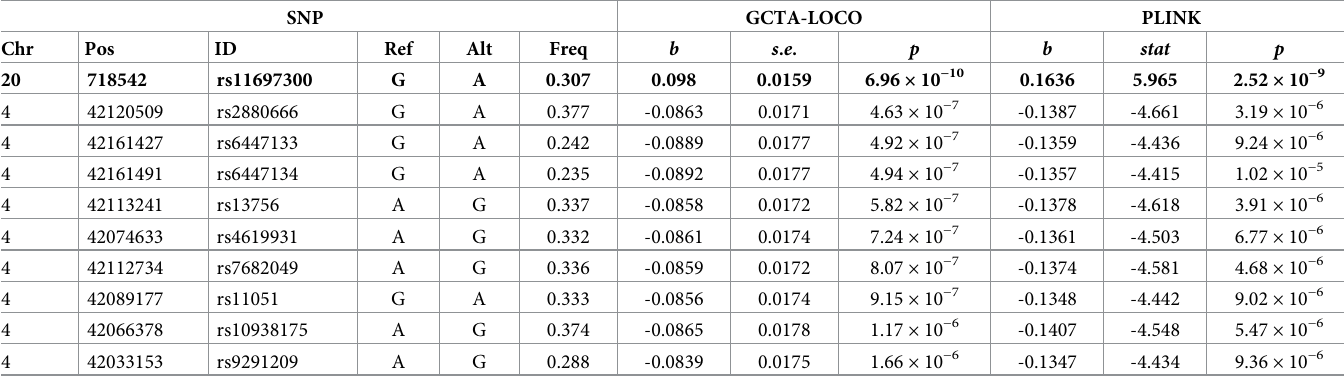
Table 1. Summary of results of genetic association